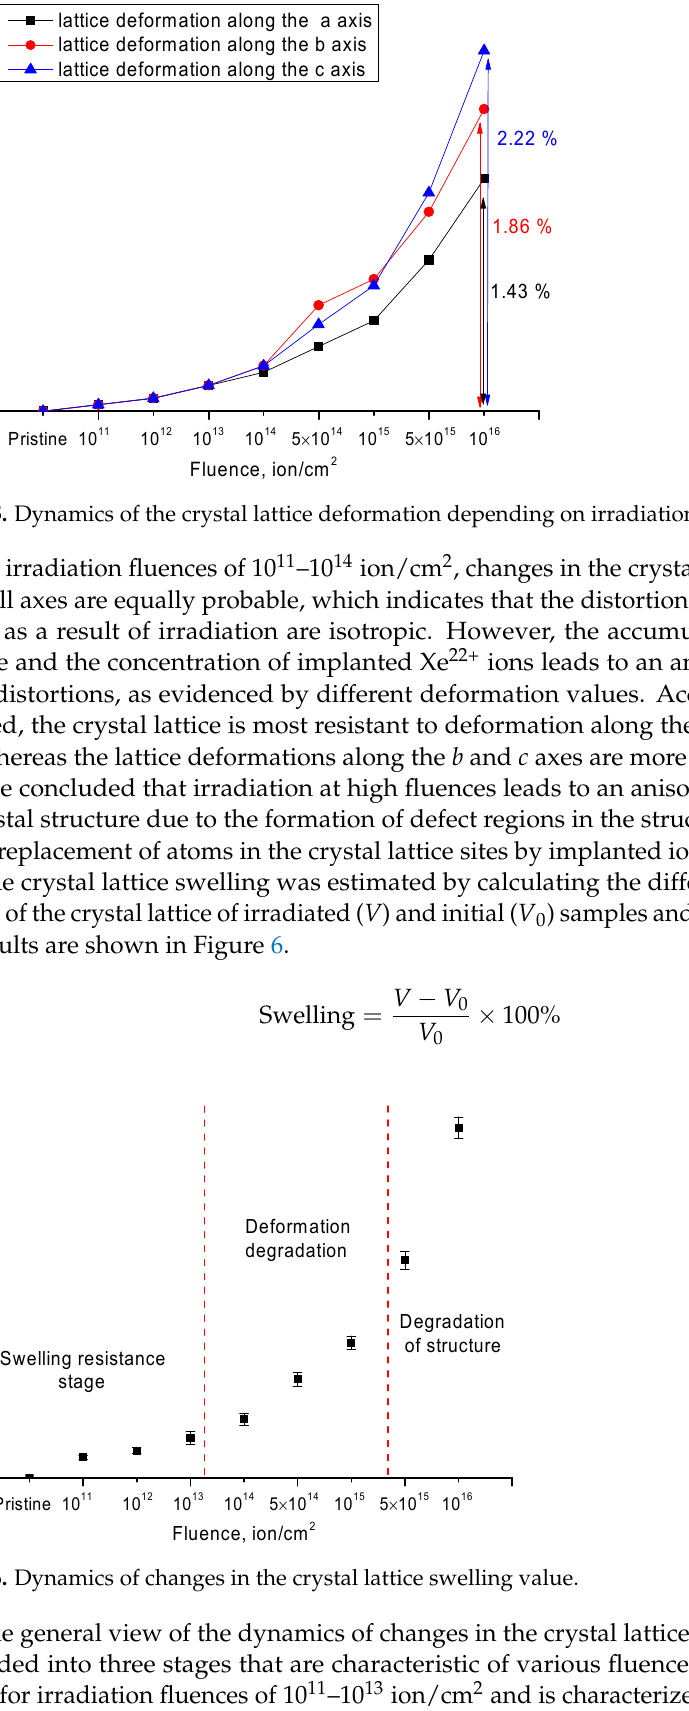
and distortion of the crystal lattice axes was estimated depending on the irradiation flu- ence. The results are shown in Figure 5.